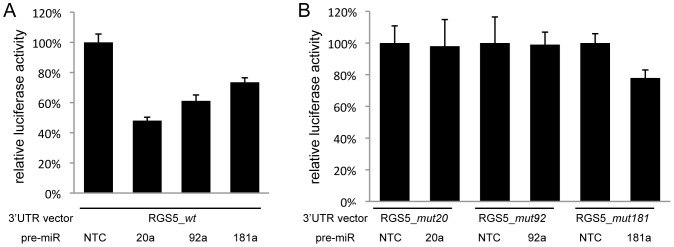
miRNA interaction with the 3′UTR of RGS5.
A. Relative luciferase activity obtained by transfecting cells with the wild type 3′UTR of RGS5 in combination with pre-miR-negative control (NTC), pre-miR-20a, pre-miR-92a and pre-miR-181a in HEK293T cells. B. Relative luciferase activity obtained by transfecting cells with mutated 3′UTR of RGS5 in combination with pre-miR-NTC, pre-miR-20a, pre-miR-92a and pre-miR-181a in HEK293T cells.